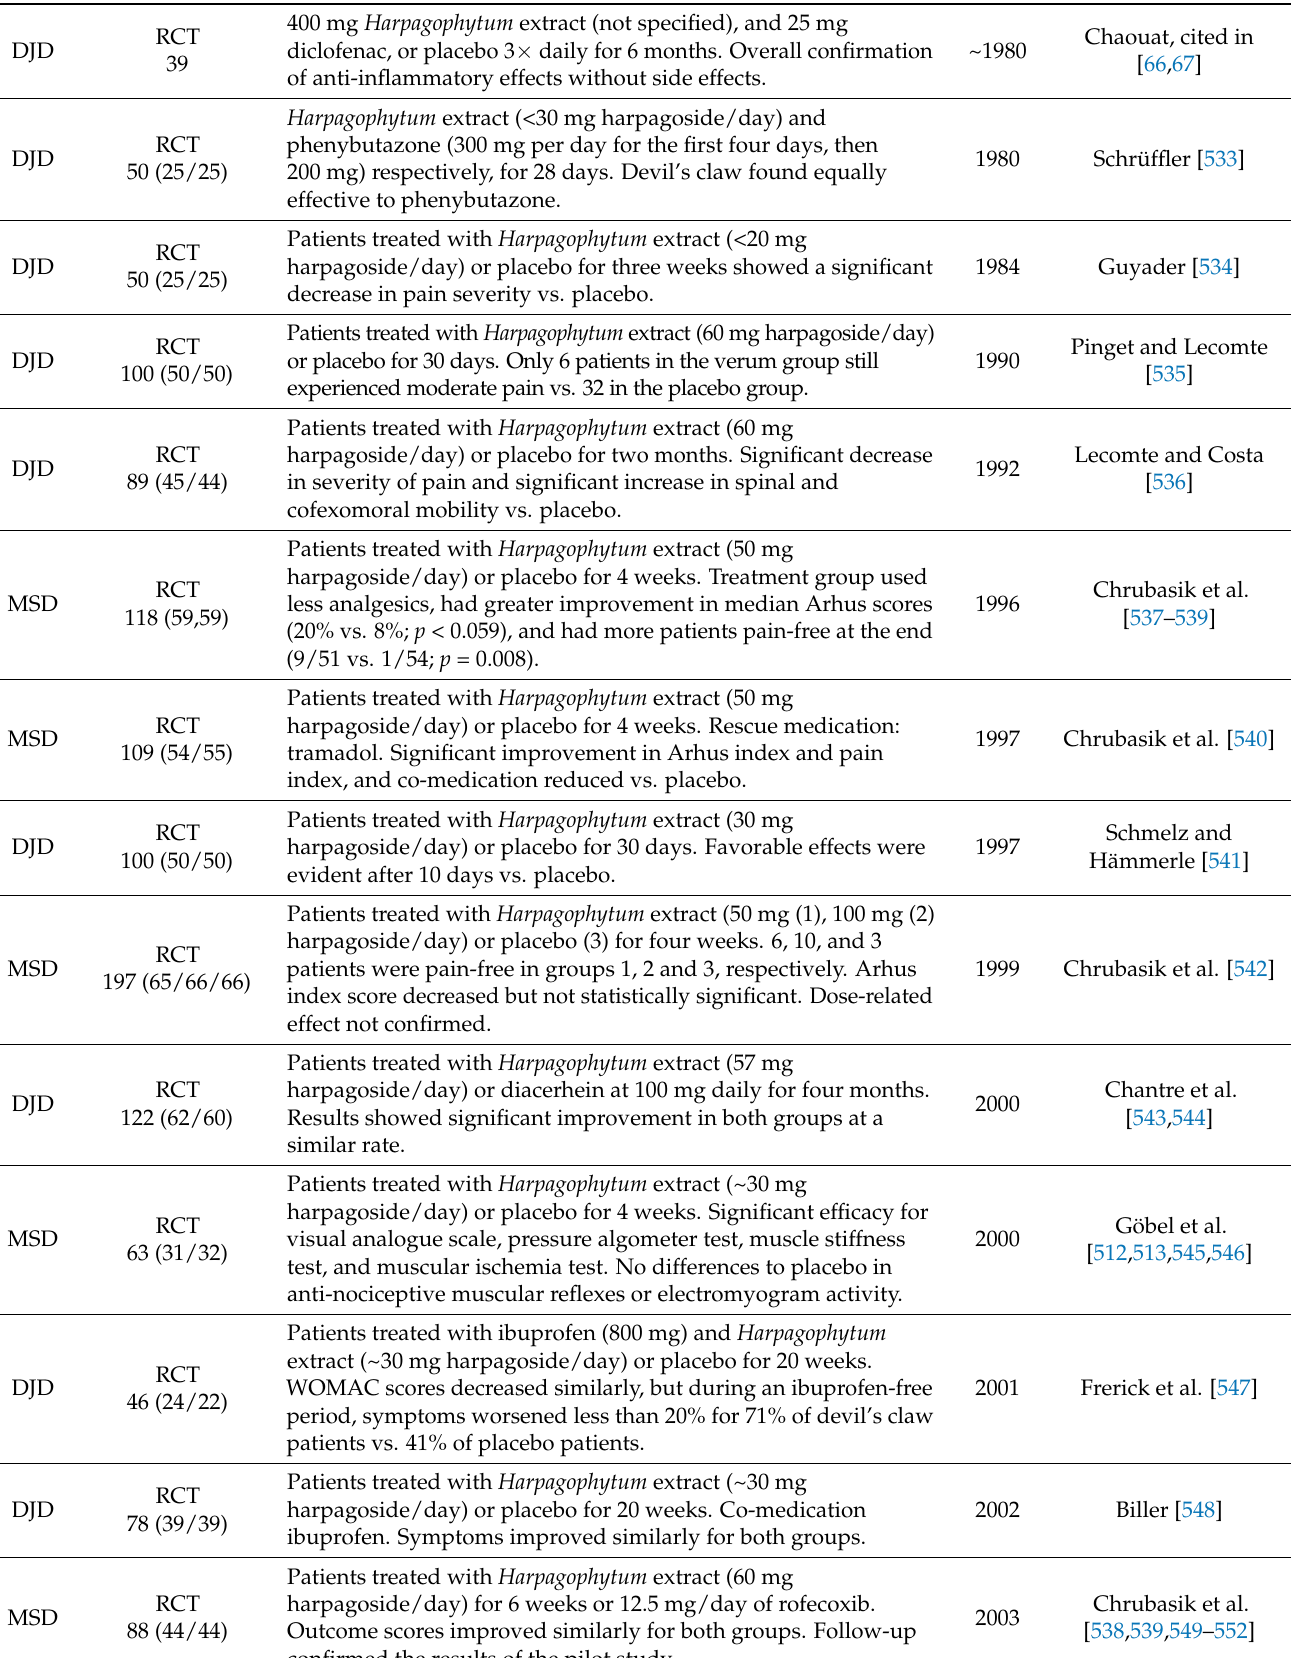
Table 11. RCTs conducted between 1980 and